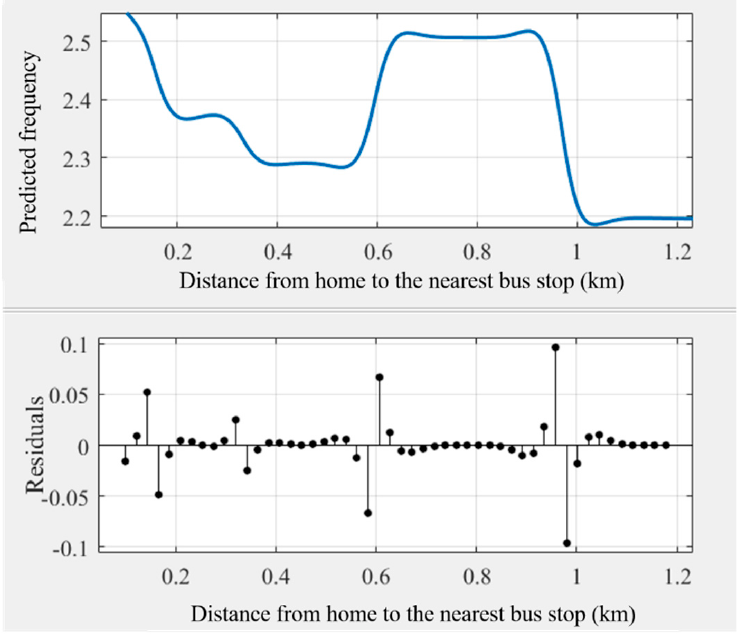
Figure 9. Nonlinear associations between the distance from home to the nearest bus stop (BUSDIST) and cycling frequency among older adults.